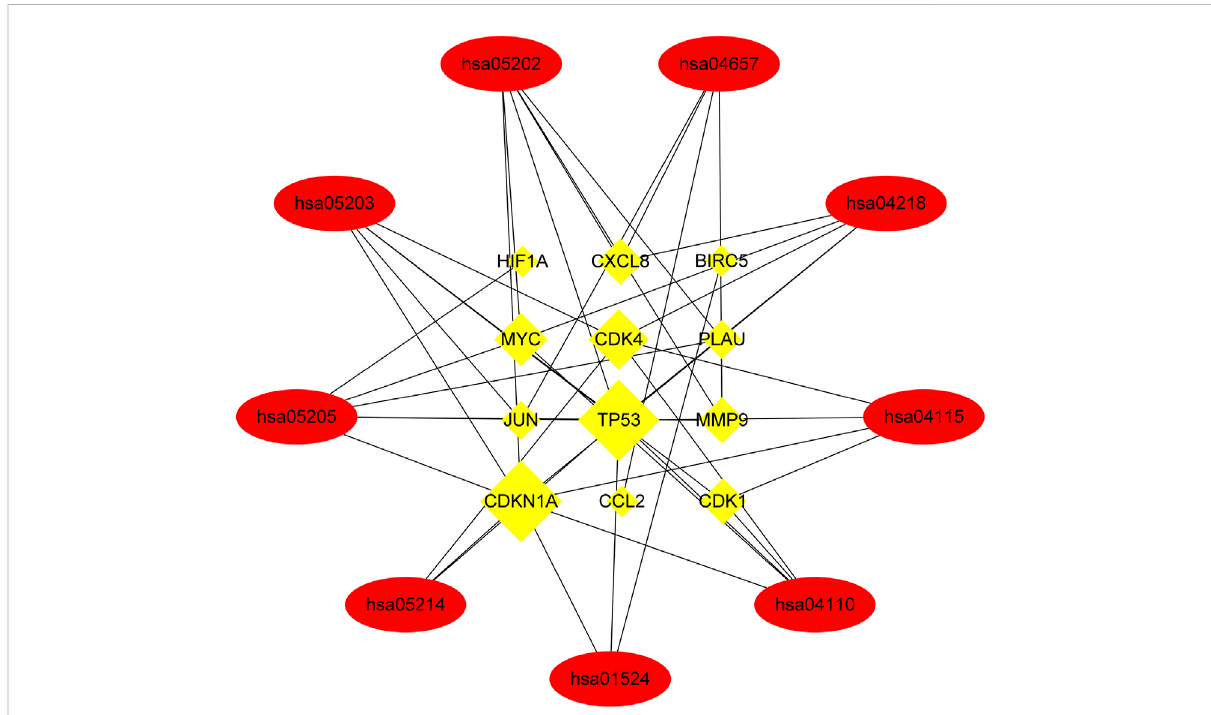
FIGURE 7 Networks of XLD drug target signalling pathways. A total of nine Kyoto Encyclopedia of Genes and Genomes signaling pathways (elliptical nodes) and 12 genes (rectangular nodes)associated with them were obtained. The size of nodes was proportional to the number of adjacent nodes. hsa,Homosapiens.Cyclin-dependentkinase1(CDK1),Interleukin-8(CXCL8),Cyclin-dependentkinase4(CDK4),Mycproto-oncogeneprotein(MYC), Cellular tumor antigen p53 (TP53),Cyclin-dependent kinase inhibitor 1(CDKN1A),Urokinase-type plasminogen activator (PLAU), Matrix metalloproteinase-9 (MMP9),Hypoxia-inducible factor 1-alpha (HIF1A),C-C motif chemokine 2(CCL2),Transcription factor AP-1 (JUN), Baculoviral iap repeat-containing protein